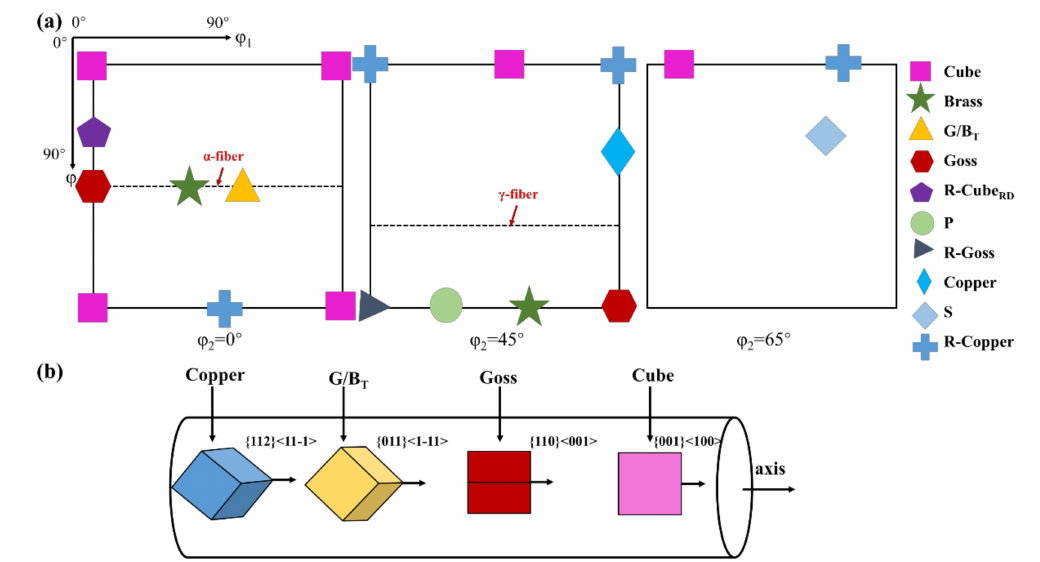
Figure 3. ( a ) ODF sections (at ϕ 2 = 0 ◦ , 45 ◦ and 65 ◦ ) of the common texture components in aluminum alloy. ( b ) the schematic diagram of the relationship between the orientation of textures: Copper, G/B T , Goss and Cube textures and the macroscopic orientation of samples.